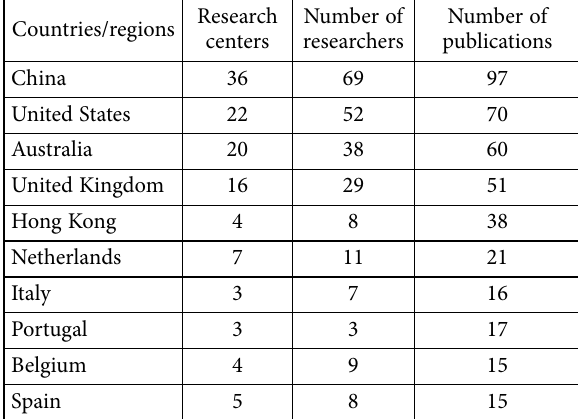
Table 2. Top 10 countries or regions by the number of